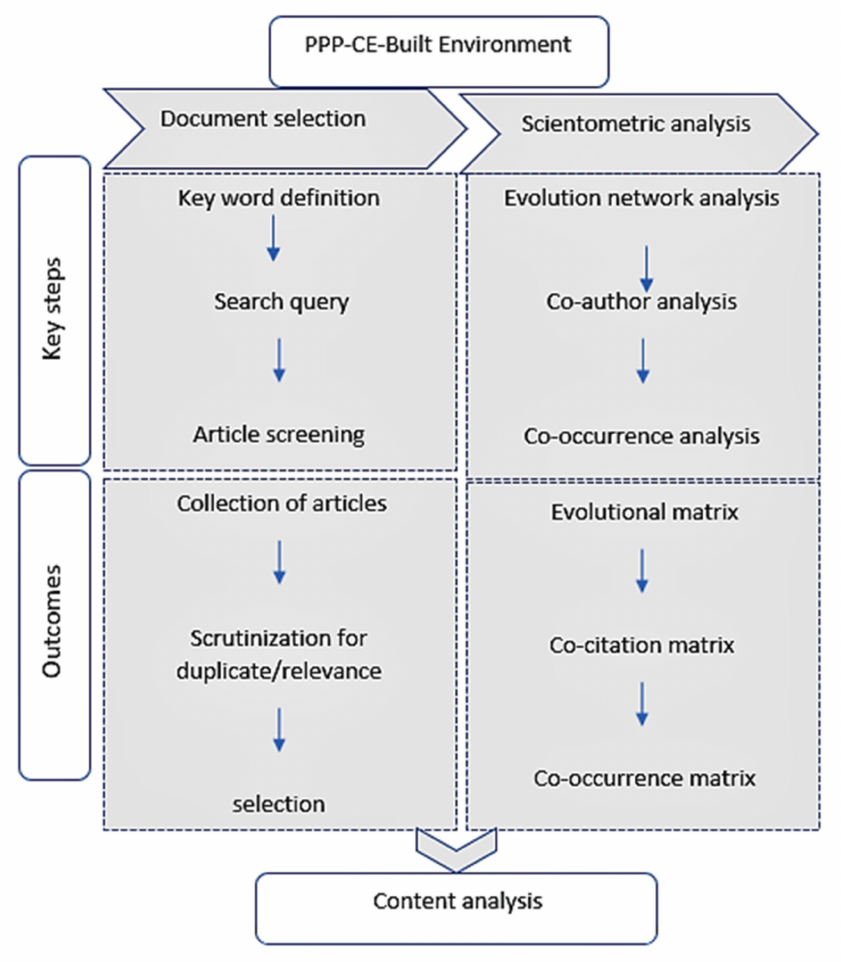
Figure 2. The framework of the